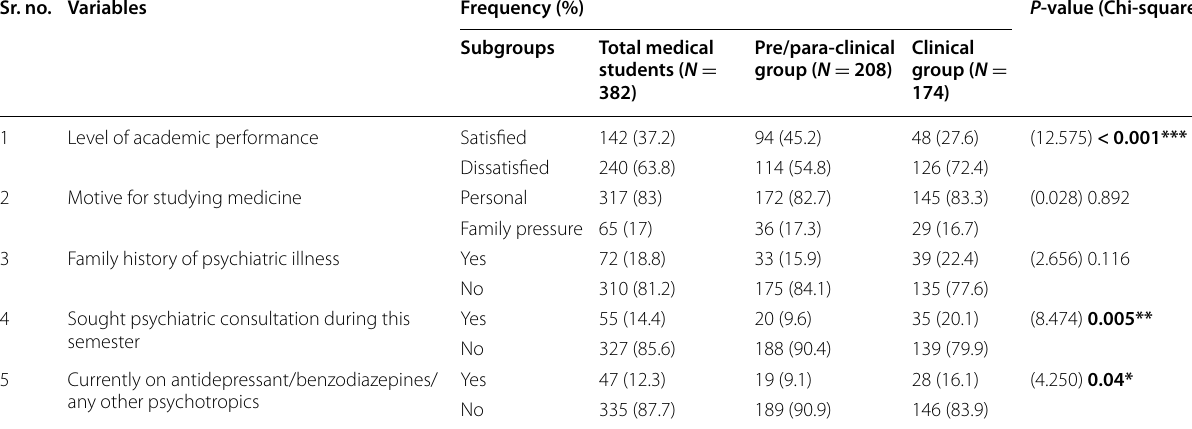
* p < 0.05, ** p < 0.01; *** p < 0.001